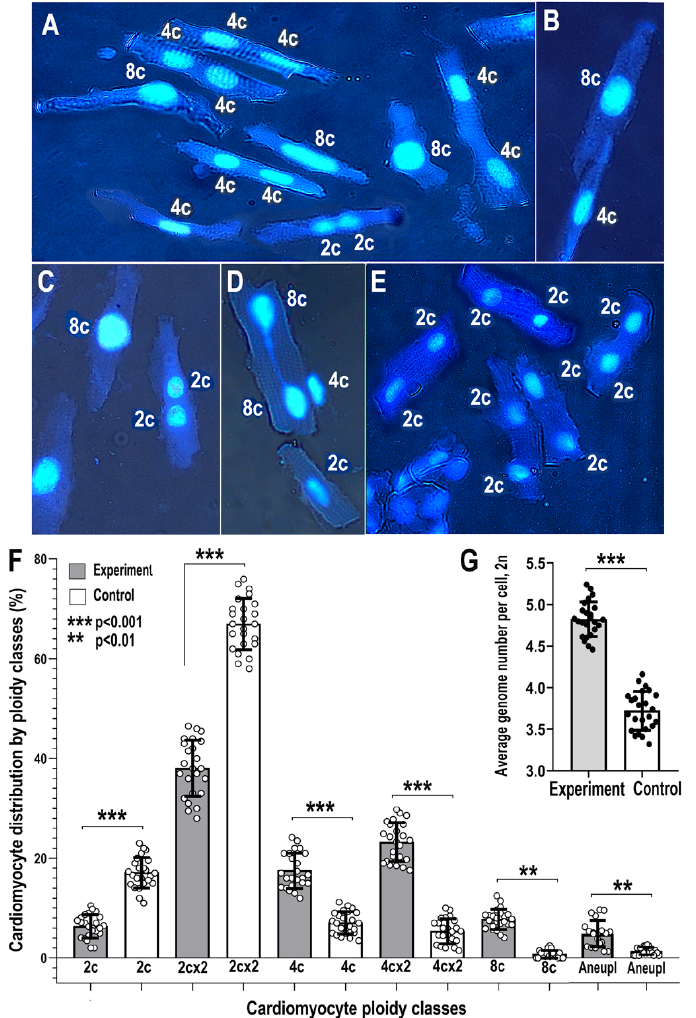
Figure 2. Increased cardiomyocyte ploidy and genetic instability in the experimental animals com- pared to the control. ( A – C )—cardiomyocytes with polyploid nuclei containing 4 or 8 genomes from the NLI survived rats. ( D )—cardiomyocytes of the experimental animal with two octaploid nuclei with a bridge between them pointing to DNA instability. This image illustrates DNA instability after NLI. ( E )—cardiomyocytes of the control animals with diploid nuclei. This image demonstrates the lower cardiomyocyte ploidy of the control animals compared to the experiment. Nuclei are stained with Hoechst 33258, double lightning, transmitted light and luminescence, phase contrast. Total magnification is × 200. ( F )—distribution of cardiomyocytes by ploidy classes in the control and experimental animals. Figure illustrates the increased percentages of tetraploid, octaploid, and aneuploid cells in the experiment compared to the control. ( G )—average cardiomyocyte ploidy levels. The figure illustrates the increase in the average cardiomyocyte genome number per cell in the experiment compared to the control. The values are presented as mean ± confidence intervals (CI), p = 0.95. The statistical significance of differences is indicated in the Figure